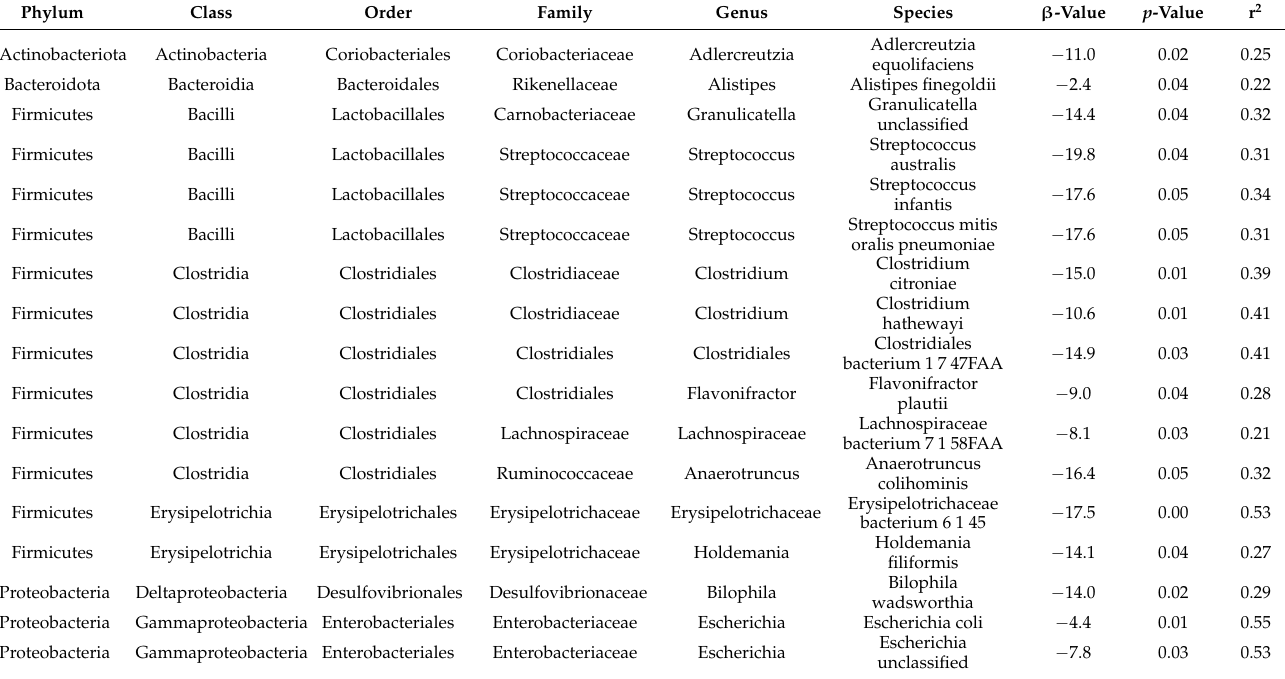
Table 4. Association between fecal microbial abundance at the species level and plasma LBP levels throughout the intervention.